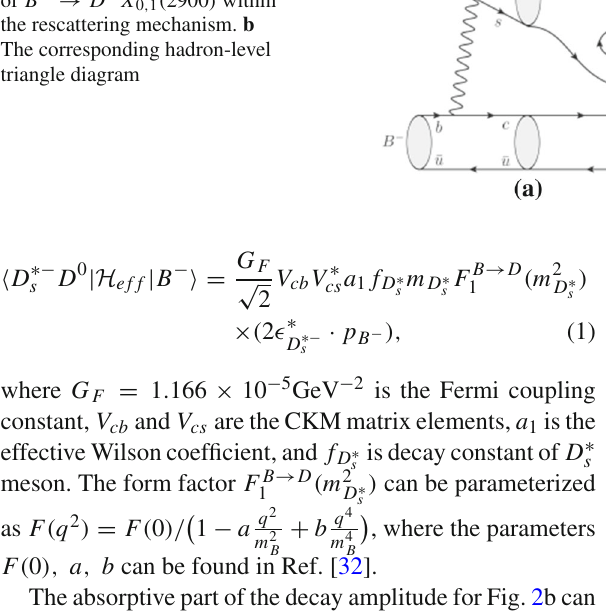
Fig. 3 The predictions on the branching fractions of B − → D − X 0 , 1 are given by the solid curves with η varying from 2.0 to 4.0. The exper- imental results are shown in dashed lines with the errors indicated by the shadow